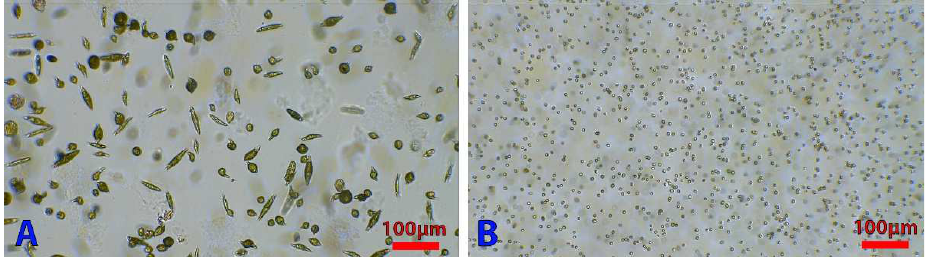
Figure 10. Examples of micrographs. Euglena gracilis ( A ) and Chlamydomonas reinhardtii ( B ) micro- graphs captured by our DIY microscope using a 2.8 mm lens that produced a 50× magnification.